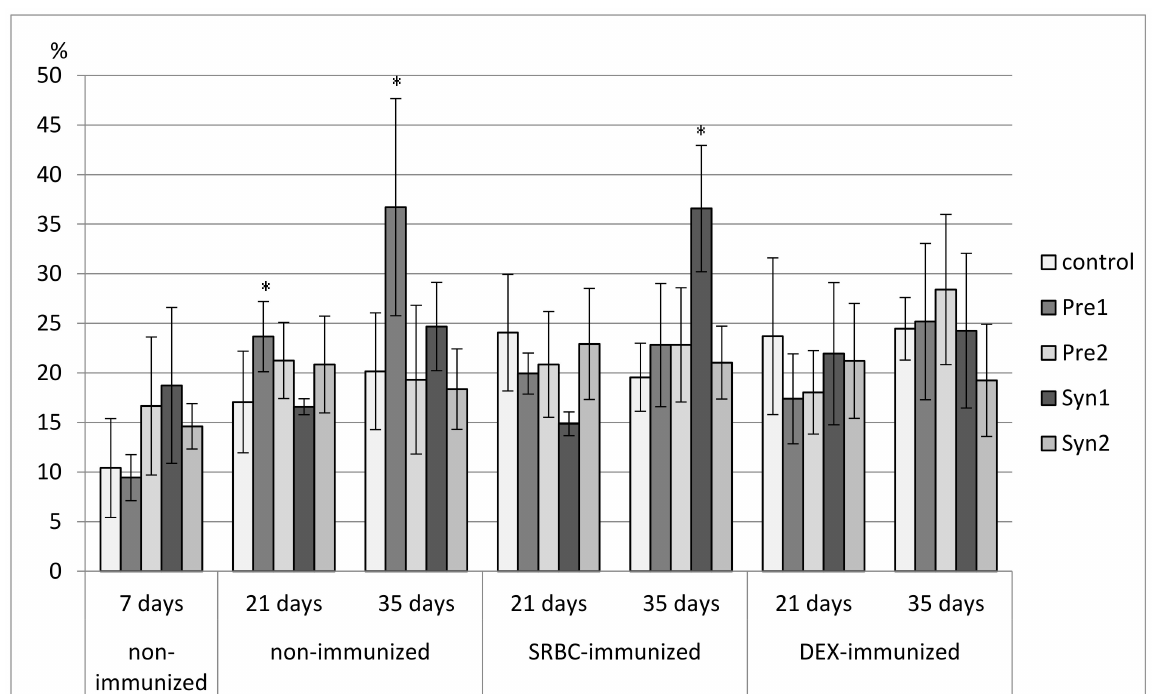
Figure 7. The percentage of Bu-1 + cells in the spleen of chicken broilers after in ovo injection of the investigated prebiotics or synbiotics. The data are expressed as the mean ± SD. Data with a symbol (*) denote a significant difference with respect to the control group ( p < 0.05).